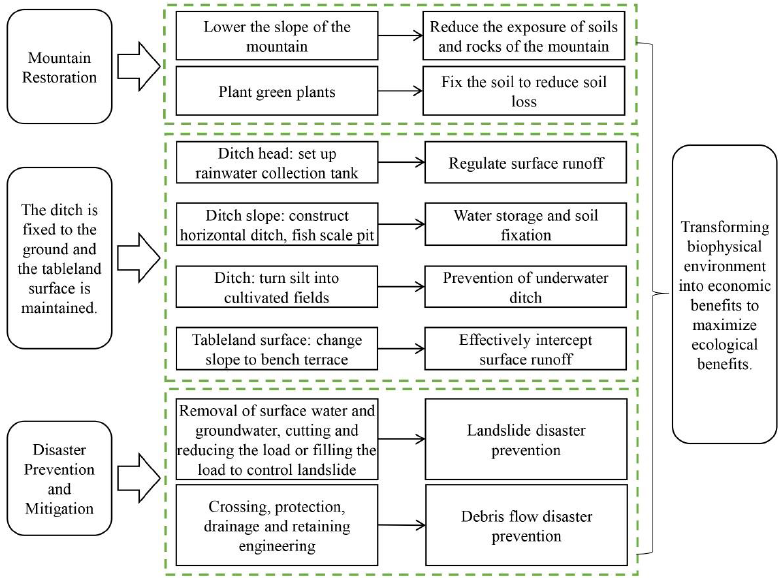
Figure 8. Schematic diagram of ecological protection and restoration.